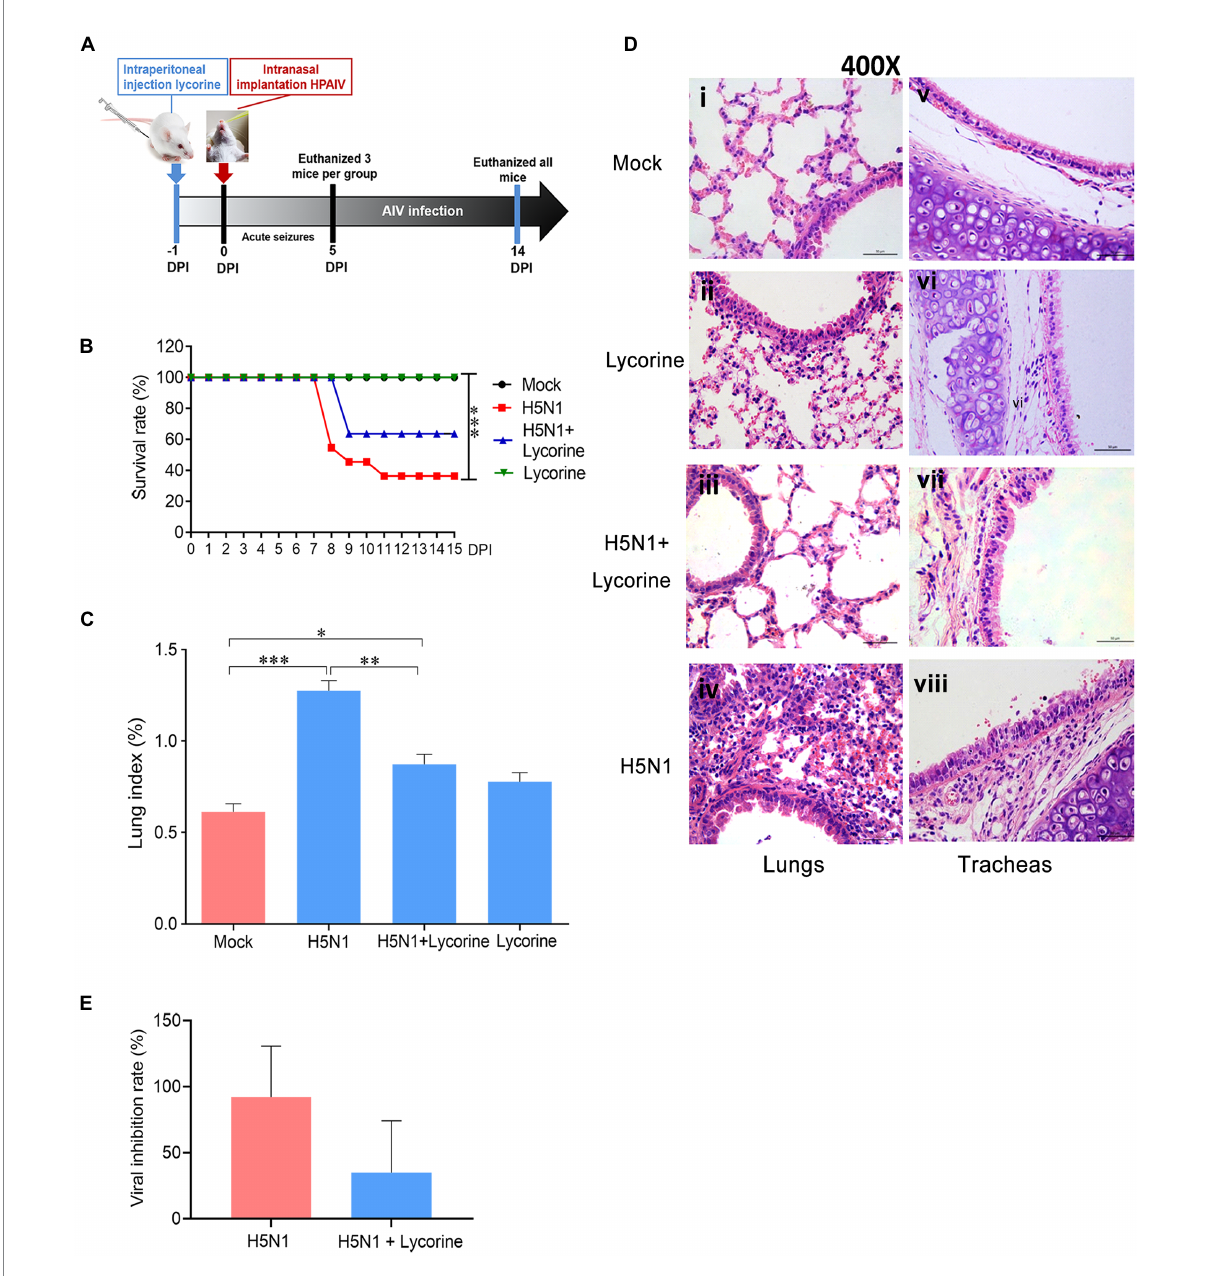
FIGURE 5 Anti-influenza effects of lycorine on the survival rate and lung index, pathological damage, and viral titers in lungs of mice. (A) In vivo schedule. The BALB/c mice ( n = 11) underwent i.p. injection with 5 mg kg − 1 day − 1 of lycorine at 24 h before infection with 2LD 50 virus and administered for 16 consecutive days. The mice from each group were randomly selected and euthanized on day 5 or 14. (B) Lycorine treatment increased the survival rate of the H5N1-infected mice. (C) Lycorine attenuated the lung indices, which were stimulated by H5N1 infection. Lung index = lung weight (g)/body weight (g) × 100. (D) Representative H&E staining images of lung and trachea tissues are shown as 400× magnification. (E) Viral titers in lung tissues of mice as determined by TCID 50 assay. Data are mean ± s.d. ( n = 5). * p < 0.05; ** p < 0.01; *** p <